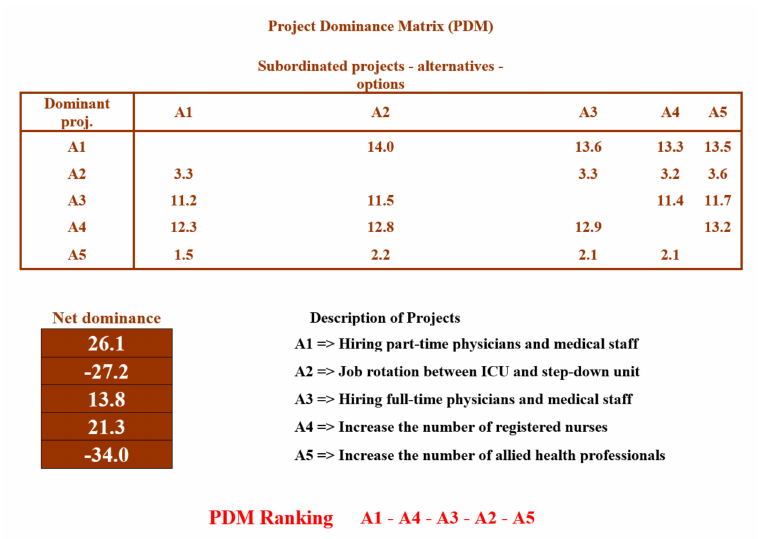
Figure A7. PDM ranking of alternatives.